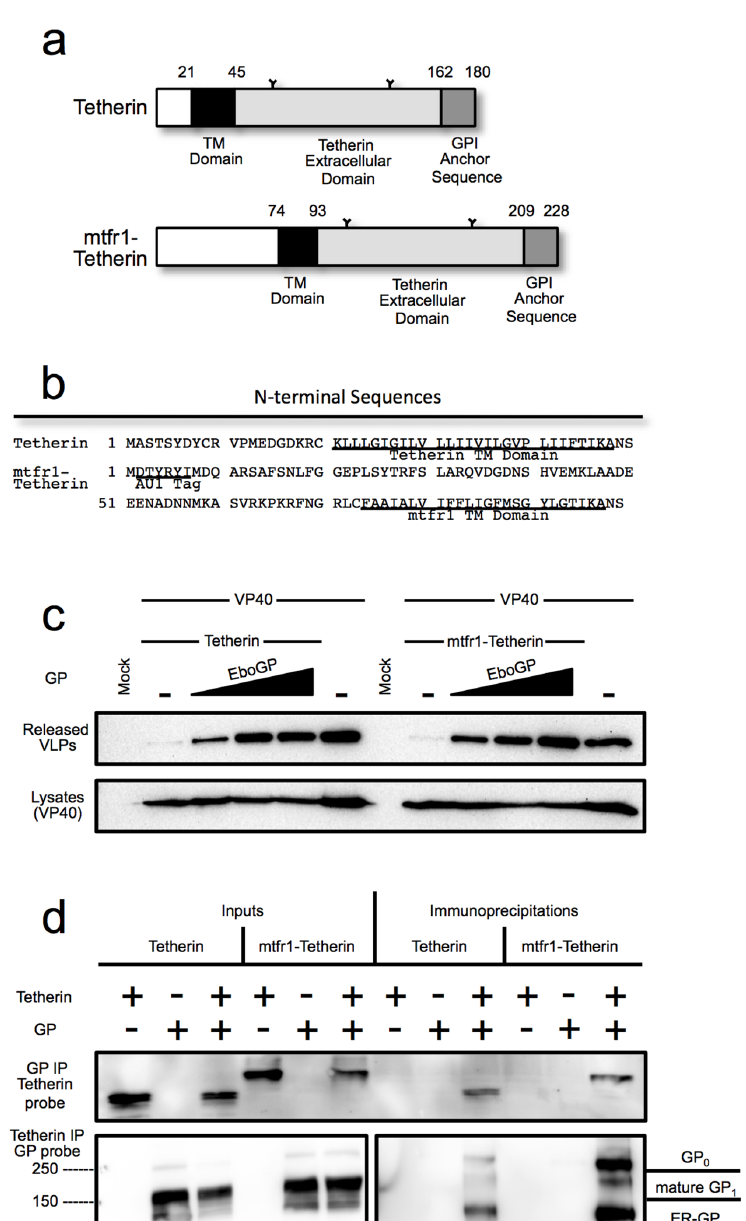
Figure 3. ( a ) Schematic diagram of human tetherin and the chimeric mtfr1-tetherin containing a cytoplasmic tail and transmembrane domain from mouse transferrin receptor 1 (mtfr1); ( b ) A comparison of the N-terminal amino acid sequence of tetherin and mtfr1-tetherin; ( c ) A budding assay comparing the ability of the Ebola virus glycoprotein to release VLPs retained by tetherin or mtfr1-tetherin. 293T cells were transfected with VP40-FLAG and increasing amounts of EboGP with either human tetherin or chimeric mtfr-tetherin as indicated. Top Panel: Purified VLPs were analyzed by SDS-PAGE/immunoblot using an anti-FLAG antibody for detection. Bottom Panel: 293T cell lysates were analyzed by SDS_PAGE/immunoblot, and probed with the anti-FLAG antibody to confirm VP40 expression; ( d ) Co-immunoprecipitation analysis comparing the ability of tetherin and mtfr1-tetherin to interact with EboGP. Lysates from 293T cells expressing tetherin and/or EboGP were analyzed by SDS-PAGE/immunoblot either directly (Inputs) or after immunoprecipitation with antibody specific for GP (top panel) or tetherin (bottom panel). Molecular mass is shown to the left in kD. The major forms of EboGP are indicated to the right. The left middle panel is a lower exposure of the right middle panel to visualize the overexposed lanes.